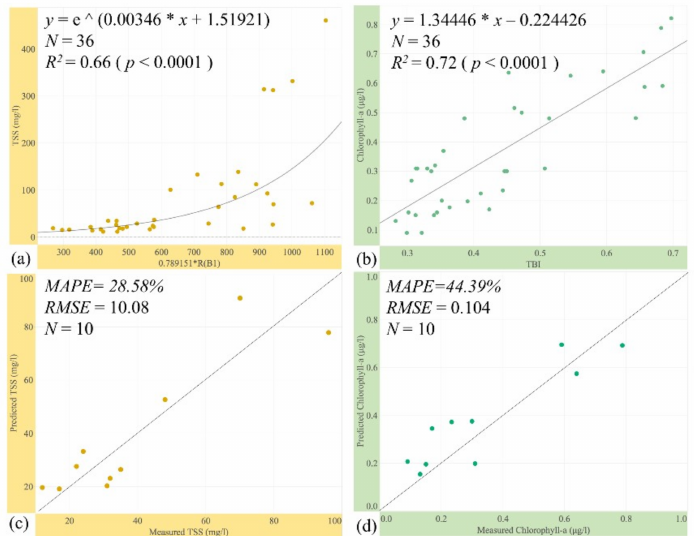
Figure 4. Scatter plot for the in situ measurement value and MODIS-based model-evaluated value of TSS ( a ) and Chla ( b ). Model accuracy test results for TSS ( c ) and Chla ( d